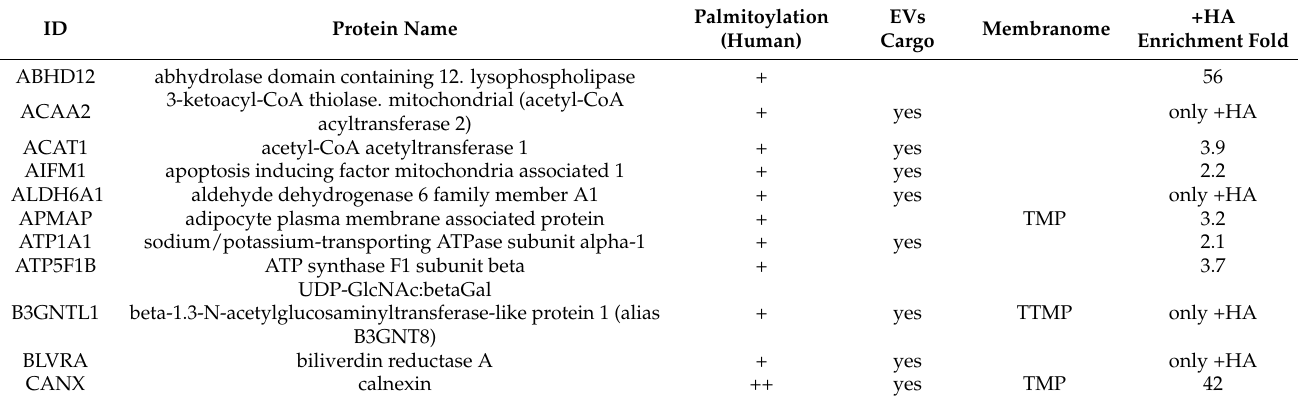
Table 1. List of palmitoylated proteins identified from bovine follicular